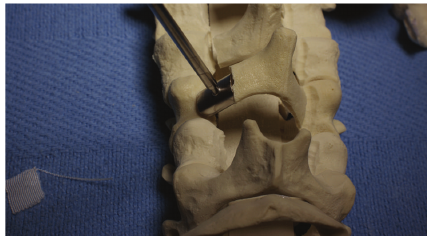
Figure 6: For titanium miniplate fixation, once the laminae are ex- panded, use atrial spacer to determine the appropriate allograft